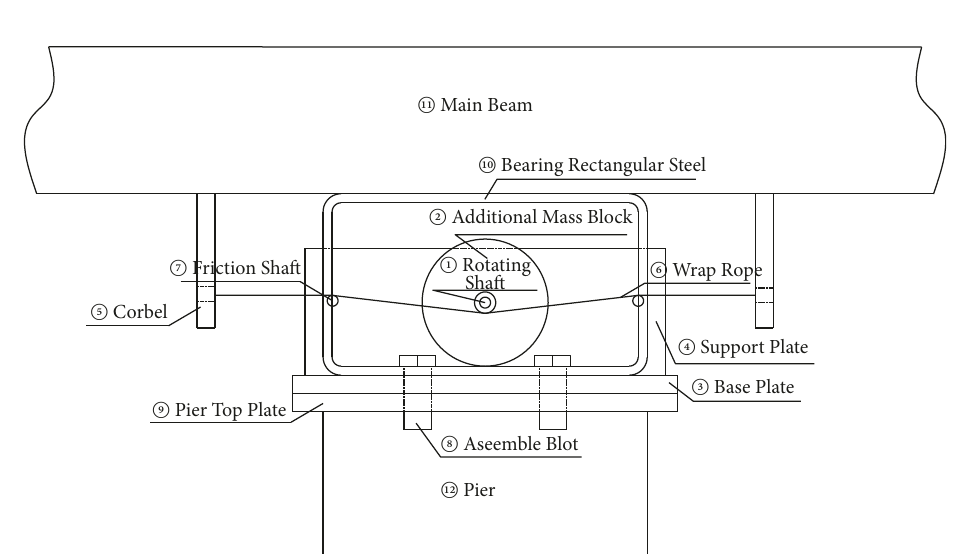
Figure 2: Arrangement of the bridge model.